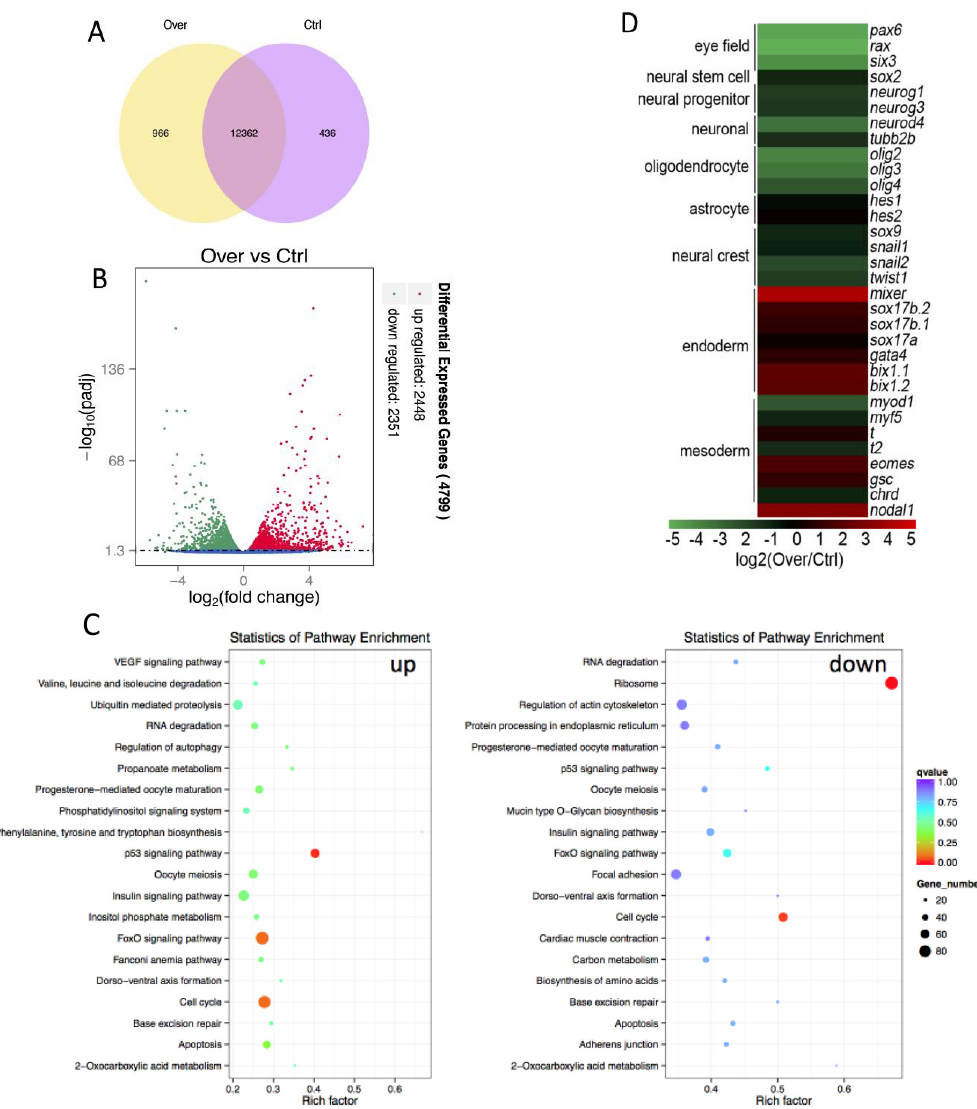
Figure 9. Transcriptomic analysis of Hes5.9 overexpression at stage 12. ( A ) Total genes nominated in a Venn diagram. ( B ) Differential expressed genes by volcano diagram. ( C ) Differentially expressed genes were annotated in KEGG pathways. ( D ) Neurogenesis associated genes were displayed.